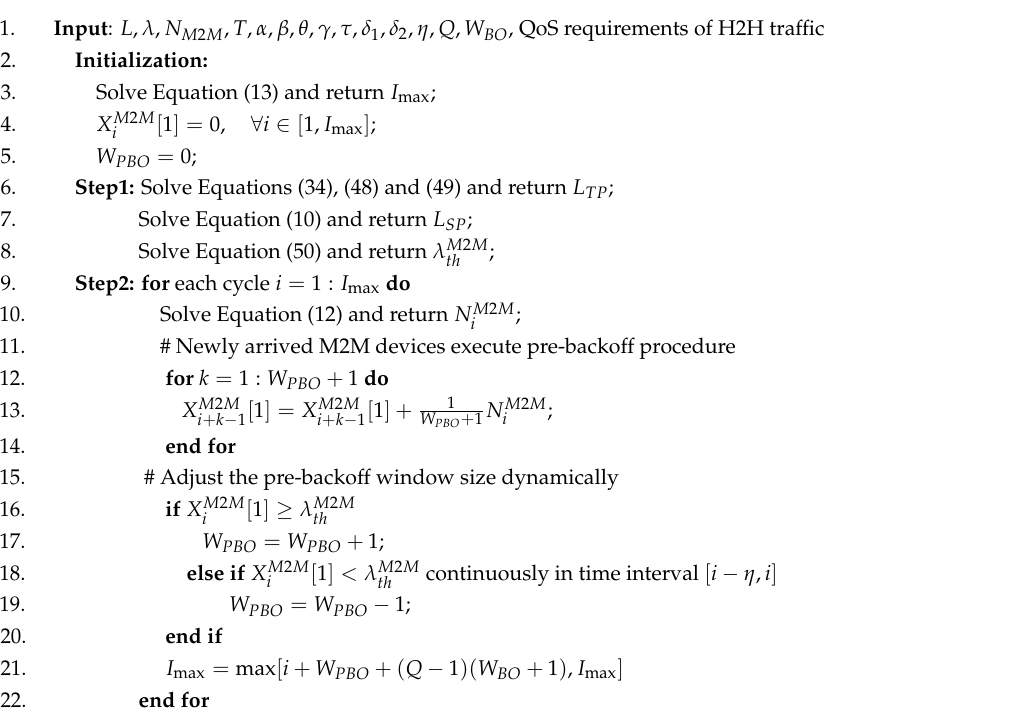
Algorithm 1: Dynamic pre-backoff algorithm